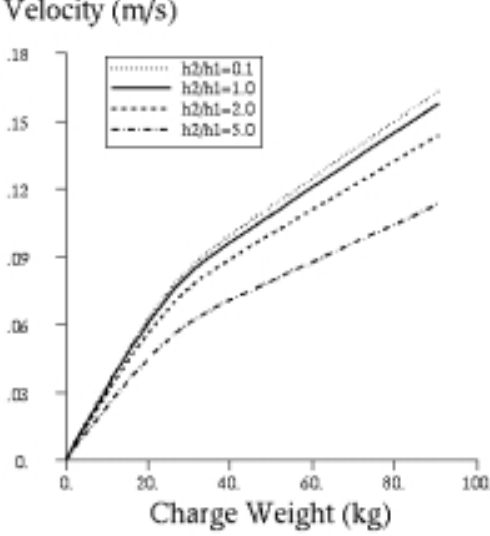
Fig. 6. Variation of internal energy density with time for different thickness ratios.